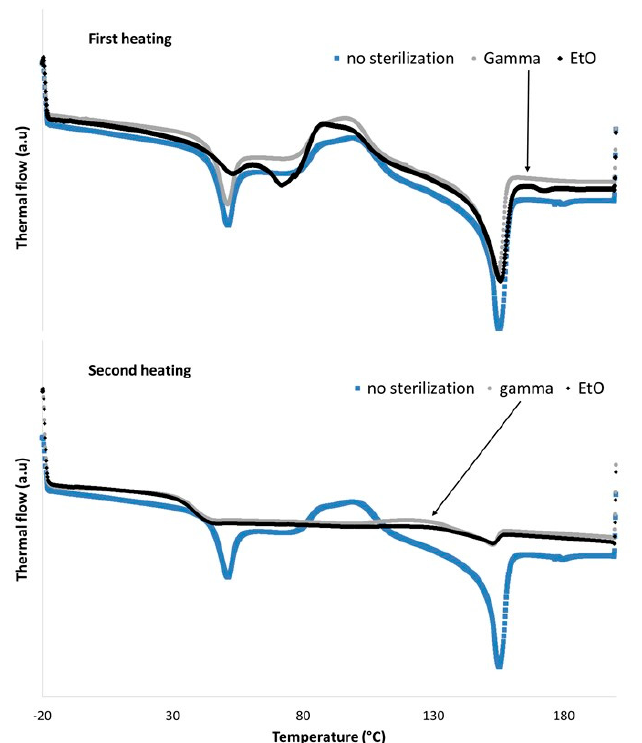
Figure 4. DSC curves of the PLGA / PLC / CHX (60:40:4) membranes before and after sterilization with gamma irradiation or EtO treatment. The two graphics show the results after the first heating cycle ( top ) and the second heating step ( bottom ).